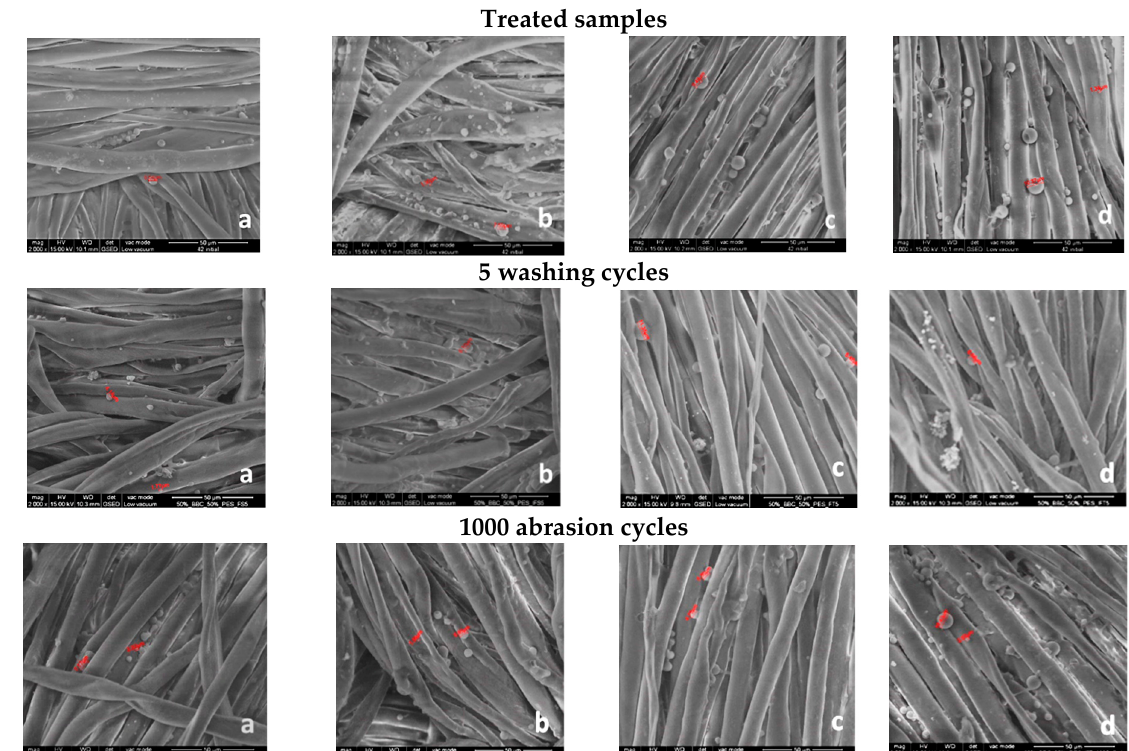
Figure 2. SEM images recorded at 2000 × magnification for 50% cotton / 50% polyester fabrics treated in different experimental variants with sage (S) and rose (R) microcapsules: ( a ) 2V 1 S, ( b ) 2V 2 S, ( c ) 2V 1 R, ( d ) 2V 2 R.